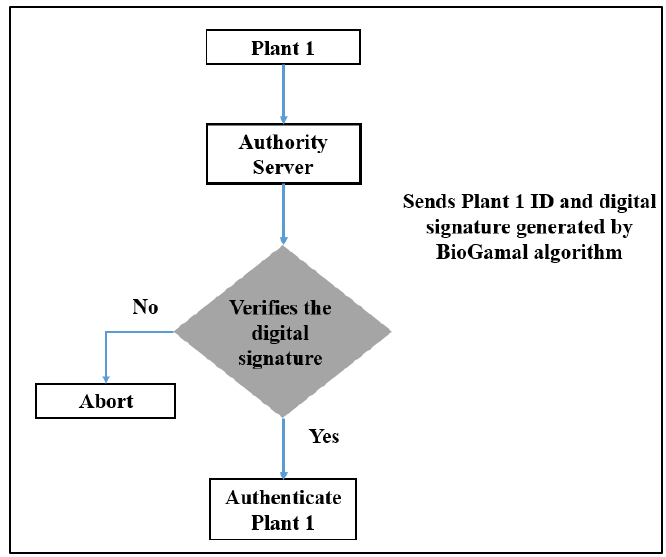
Figure 3. Authentication Mechanism on Kanban